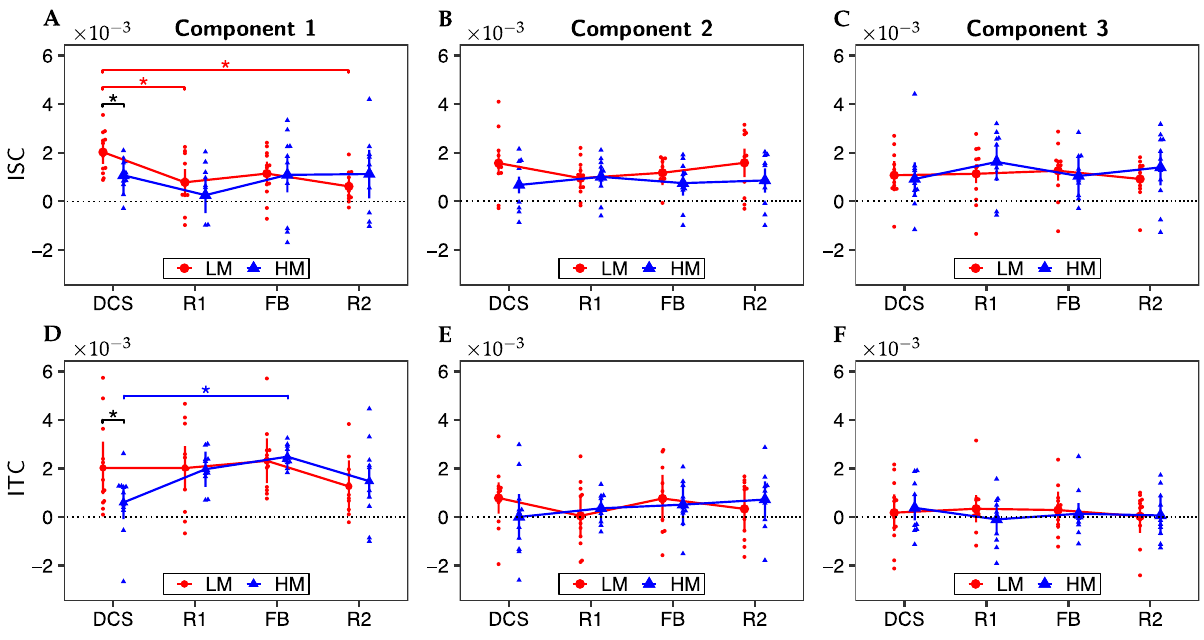
Figure 4. Results of the first three CorrCA components for ( A – C ) ISC and ( E – F ) ITC in response to LM (red; n = 12 ) and HM (blue; n = 11 ) decision-making tasks during four experimental periods, namely, decision (DCS), first rest (R1), feedback (FB), and second rest (R2). Significant differences between a period pair or between LM and HM tasks are marked as ‘*’ for p < 0.05 after FDR